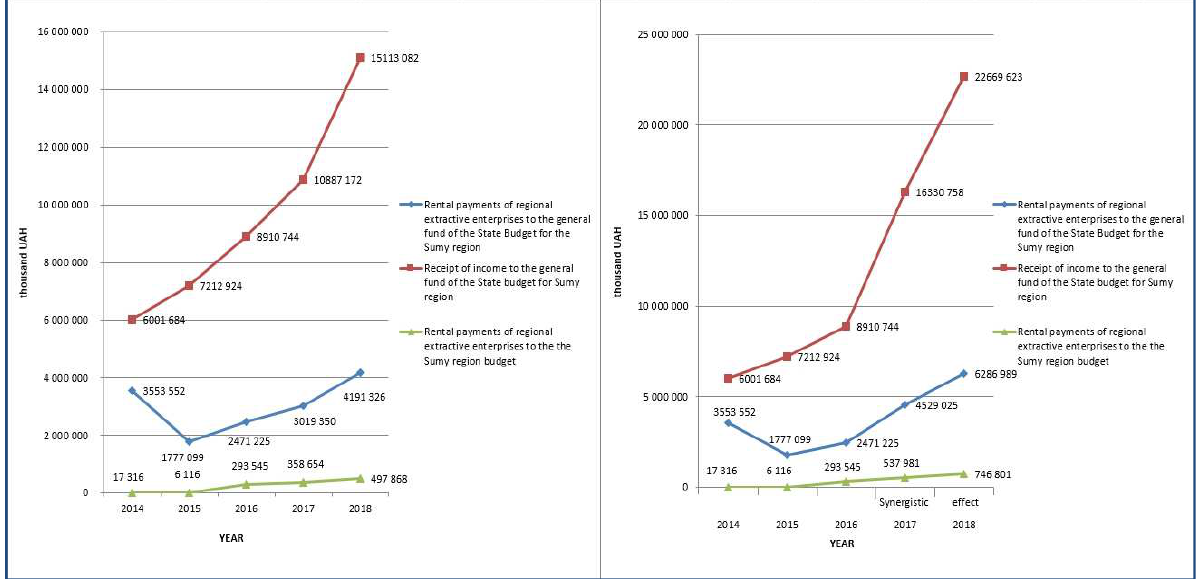
Fig. 1. Determination action of the synergistic effect of the collaborative alliance in the state-region-enterprise